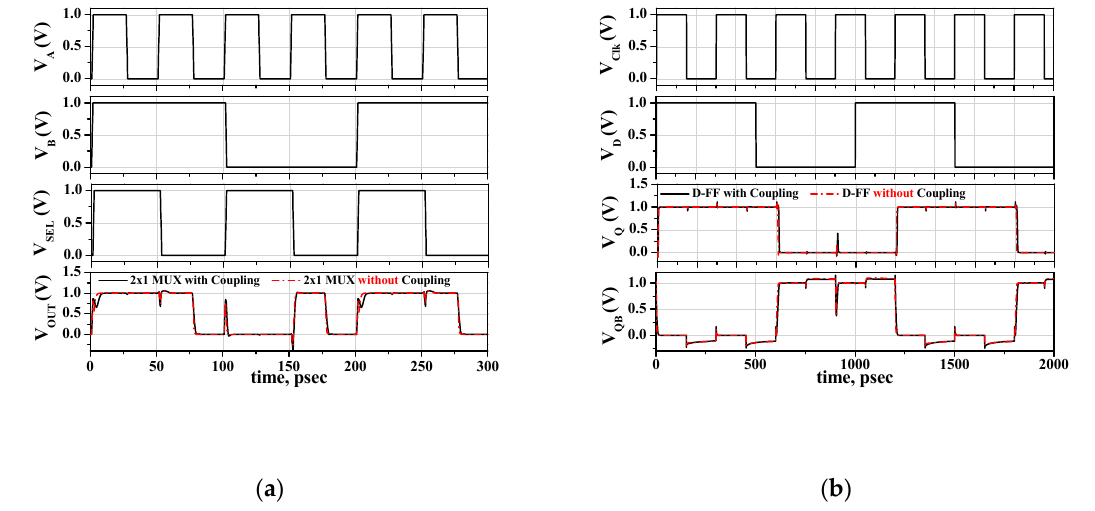
Figure 8. Transient response HSPICE simulation results of ( a ) 2 × 1 multiplexer and ( b ) D flip-flop. Table 3. Performance comparison of M3DI logics with / without electrical coupling.